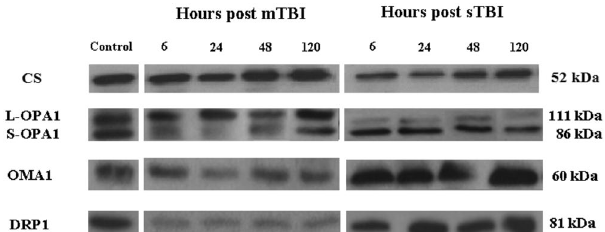
Figure 6. Representative Western blot analysis of the expression of citrate synthase (CS) as a measure of mitochondrial mass, and of proteins involved in fusion (L-OPA1, S-OPA1, OMA1) and fission (DRP1). The analysis was carried out in brain tissue homogenates of rats receiving TBI of graded severity (mTBI and sTBI) at different times